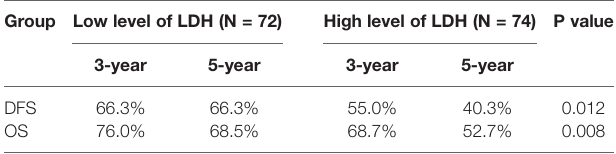
TABLE 7 | Survival analysis for patients with T3 – 4.